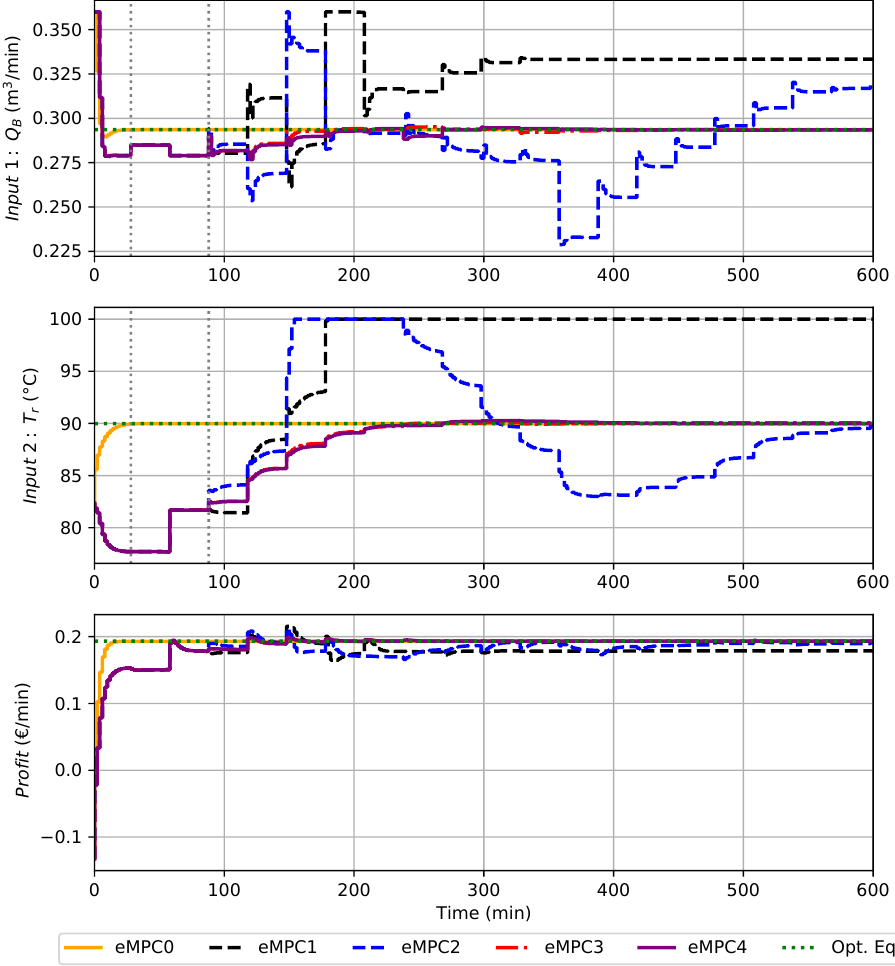
Figure 5. Performance of the Williams–Otto reactor with five controllers and no measurement noise: inputs ( top and middle ) and profit ( bottom ). The dotted vertical lines depict the time interval of 30–90 min used for Λ